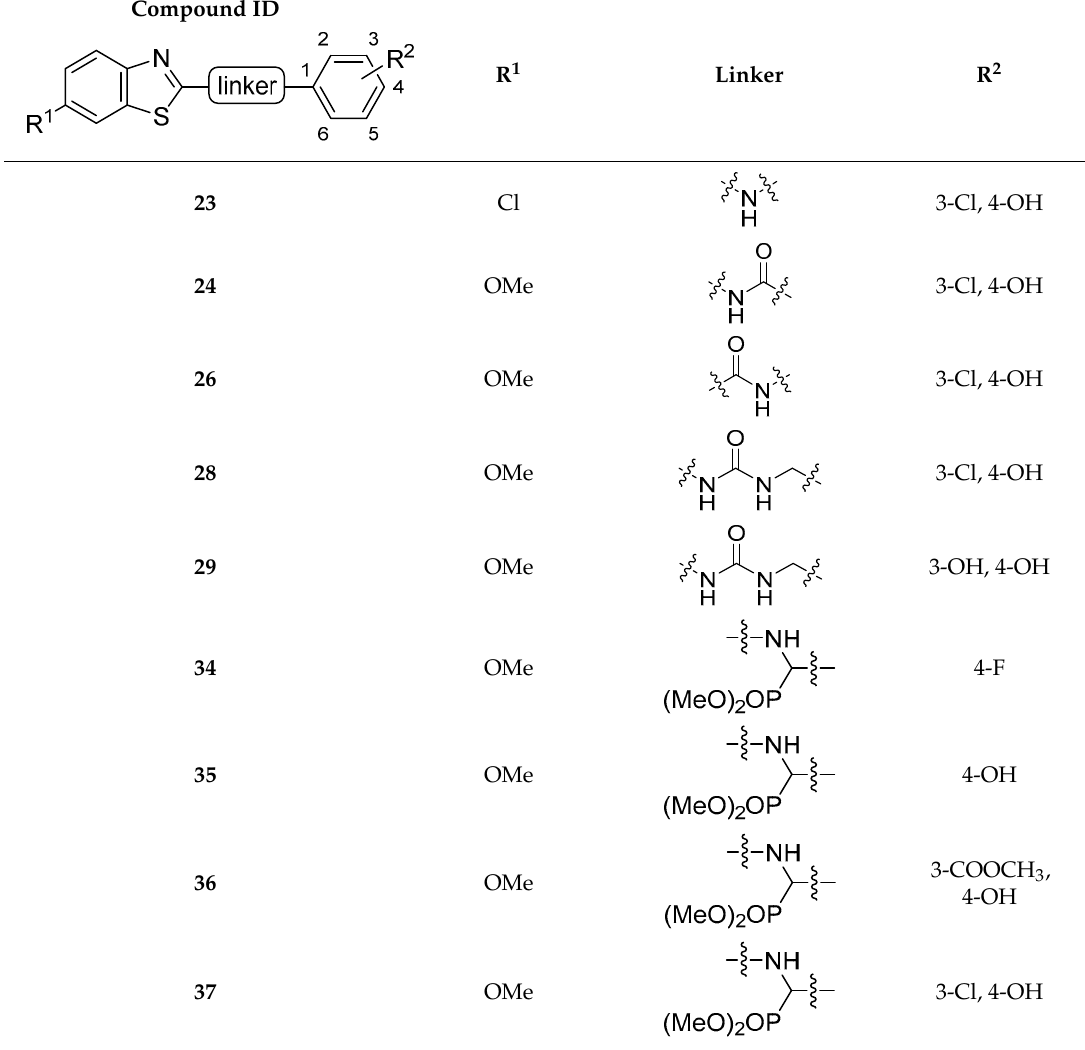
Table 2. Second series of prepared compounds ( 23–49 ).